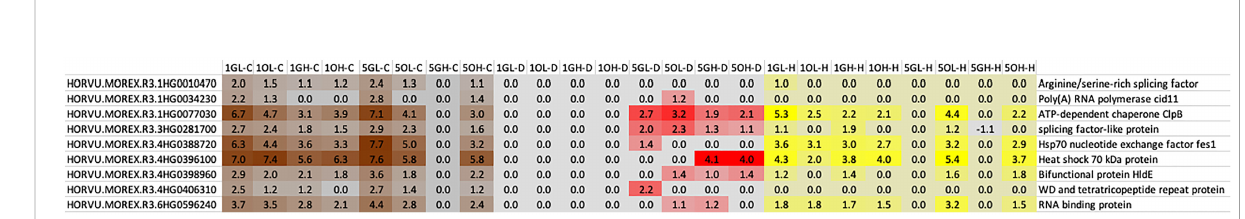
FIGURE 11 The nine hub genes identi fi ed in the darkred module for heat, drought, and combined stress in barley. Hub genes were selected based on the topological coef fi cients (<0.4) and closeness-connectivity values (>0.8). The matrix shows the differential expression values for each time point (1 or 5), genotype (Golden Promise-G and Otis-O), tissue type (L-Leaf; H-Head) and stress (D: Drought; H: Heat; C: Combined stress). The intensity of the color within each (brown: combined stress; Yellow: Heat; Red: Drought) indicates the extent of differential expression of the hub genes. The left column shows the gene identi fi ers, and the right column shows the IPK gene